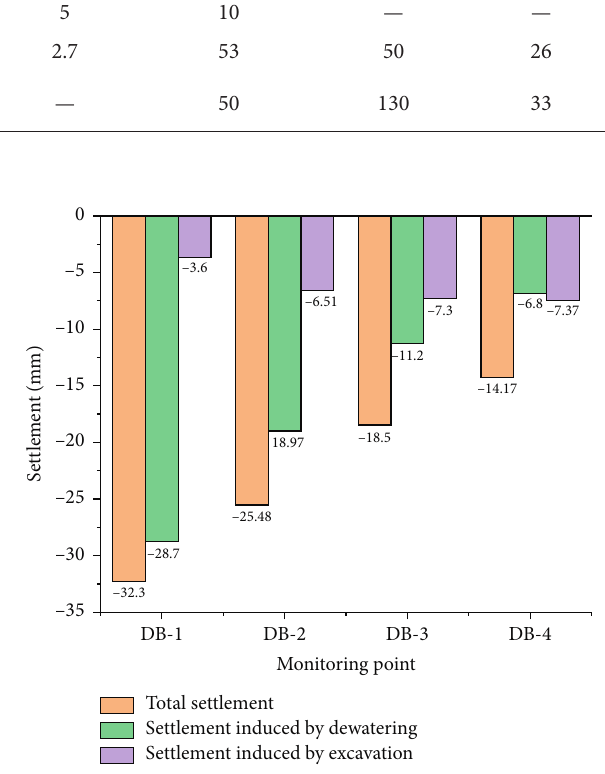
Figure 5: Theoretical calculation of surface